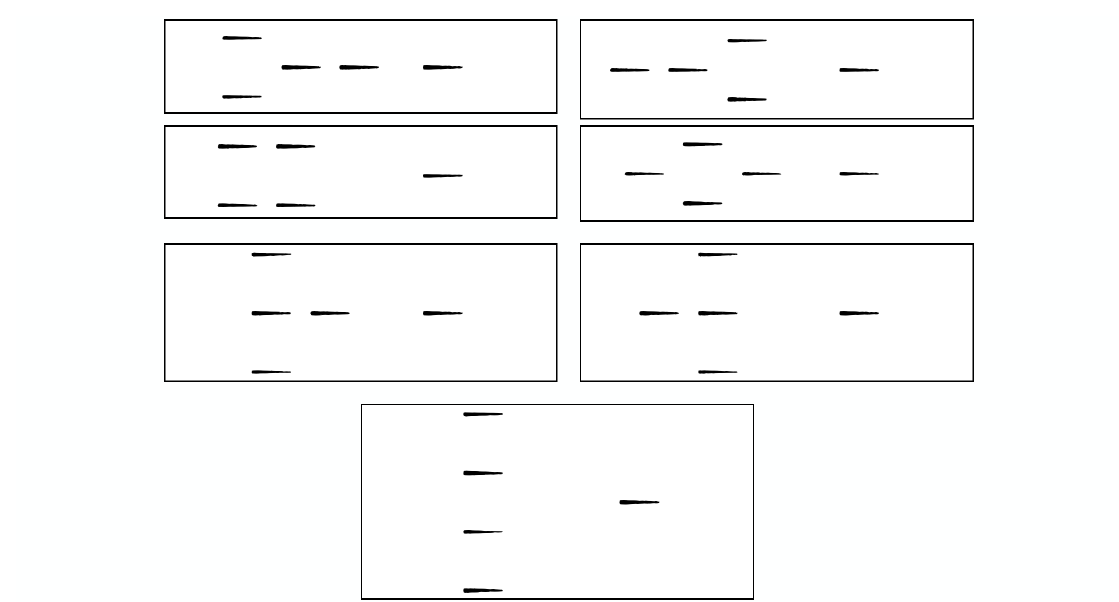
Figure A3. Configurations for four leading